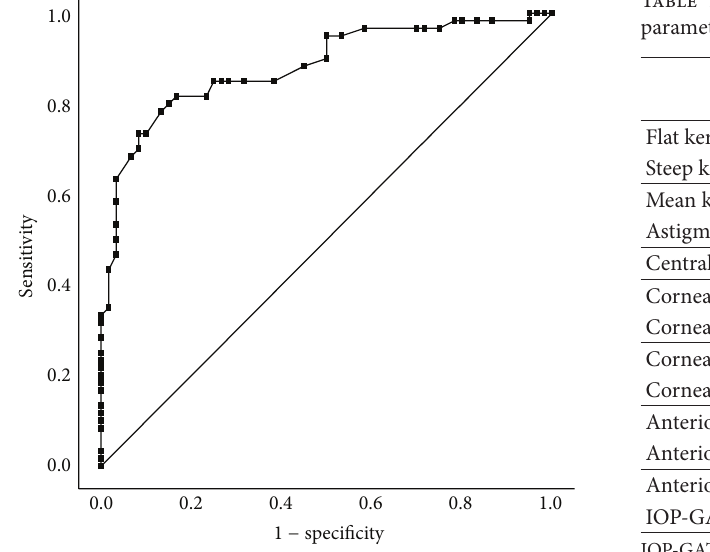
Figure 3: ROC curve (graphical plot of the sensitivity versus false positive rate) for DA. The cutoff was 1.18mm, with 81.7% sensitivity and 83.3% specificity (test accuracy, 82.5%).